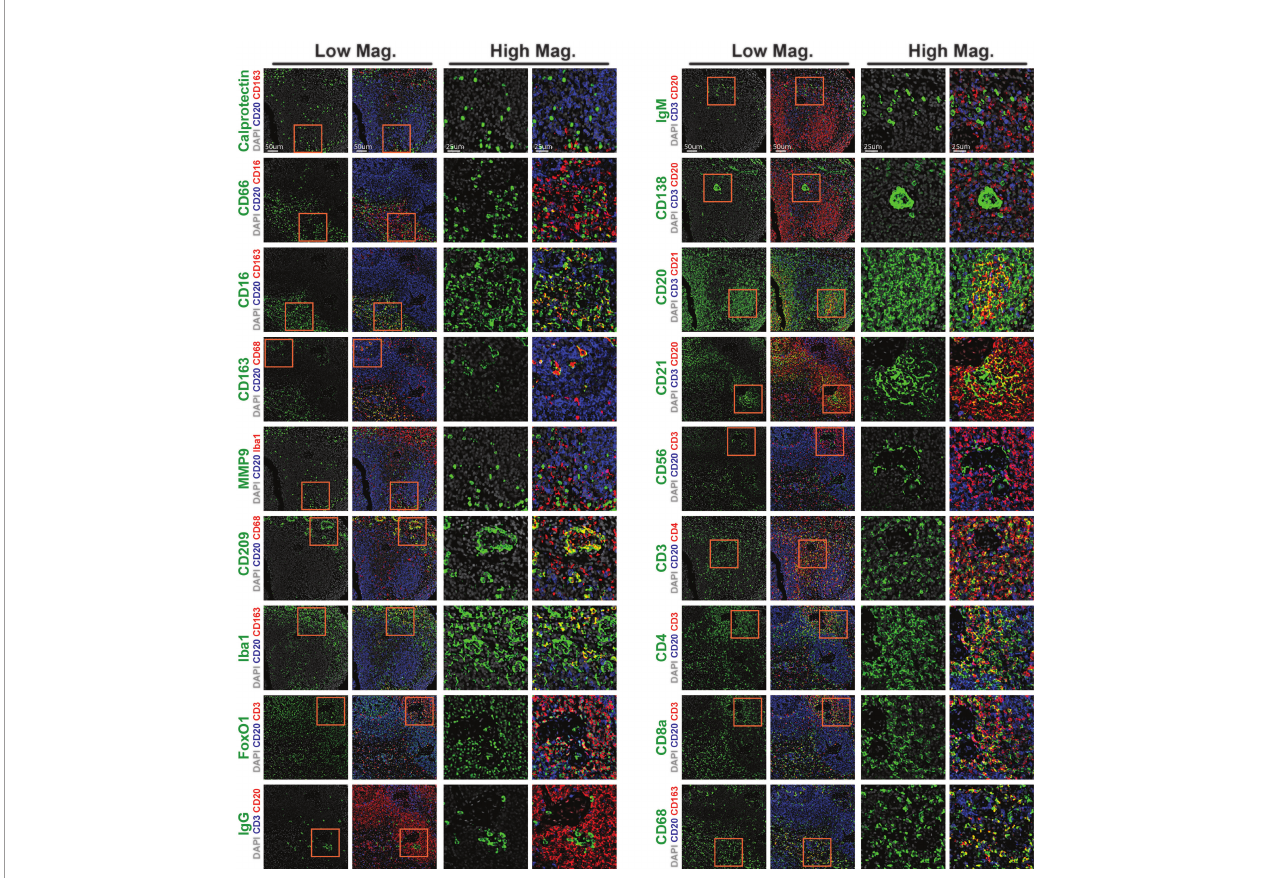
FIGURE 3 | CODEX validation of antibodies targeting rhesus immune tissues. Representative low magni fi cation (left) and high magni fi cation (right) CODEX images for indicated markers (green). Markers are shown relative to nuclear stain only (DAPI, grey, left), or overlayed with co-staining (red) and counterstaining (blue) markers to demonstrate speci fi city (right). Inlaid orange boxes on low magni fi cation images indicate the magni fi ed